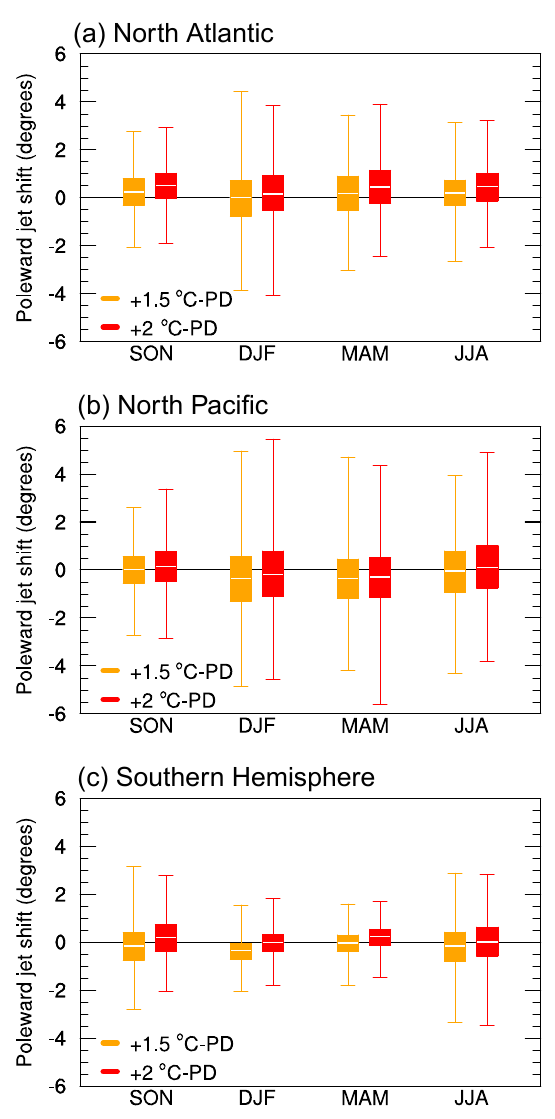
Figure 6. Multi-model mean shift of the eddy-driven jet in the 1.5 ◦ C (orange) and 2.0 ◦ C (red) experiments relative to the PD experiment for each season (a) North Atlantic sector (60 ◦ W–0), (b) North Pacific sector (135–235 ◦ E), and (c) Southern Hemi- sphere. The white horizontal line in the boxes indicates the median, the boxes indicate the interquartile range, and the whiskers indicate the spread across all ensemble members for all models. Jet latitude is determined according to the method of Woollings et al. (2010). The mean shifts are very close to, but different from, zero based on 95% confidence intervals from 10000 bootstrapped realisations of the full HAPPI ensemble (926 members over all models), with the exception of the following seasons/sectors: for 1.5 ◦ C–PD, North Atlantic DJF, North Pacific JJA/SON, Southern Hemisphere MAM; for 2.0 ◦ C–PD, North Pacific DJF/JJA/SON, Southern Hemisphere DJF/JJA.